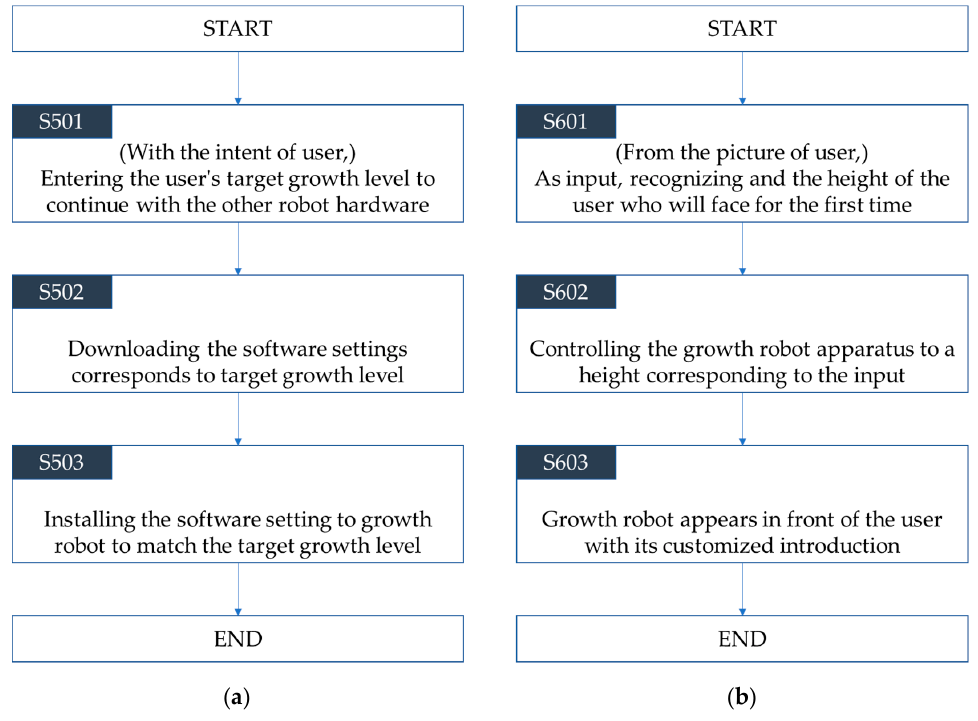
Figure 9. Robot settles: ( a ) S500s: Donor to the target user; ( b ) S600: Reconfigure to the new user in other modes. A flowchart showing a method of controlling the software function of the growth robot apparatus.